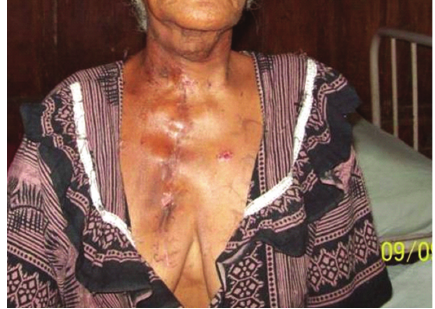
Figure 7: Postoperative